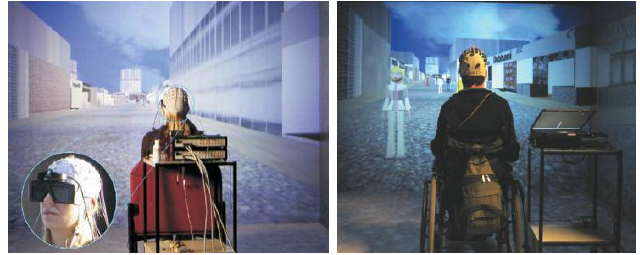
Fig. 9. User walks in a virtual street imagining feet movement. Source: